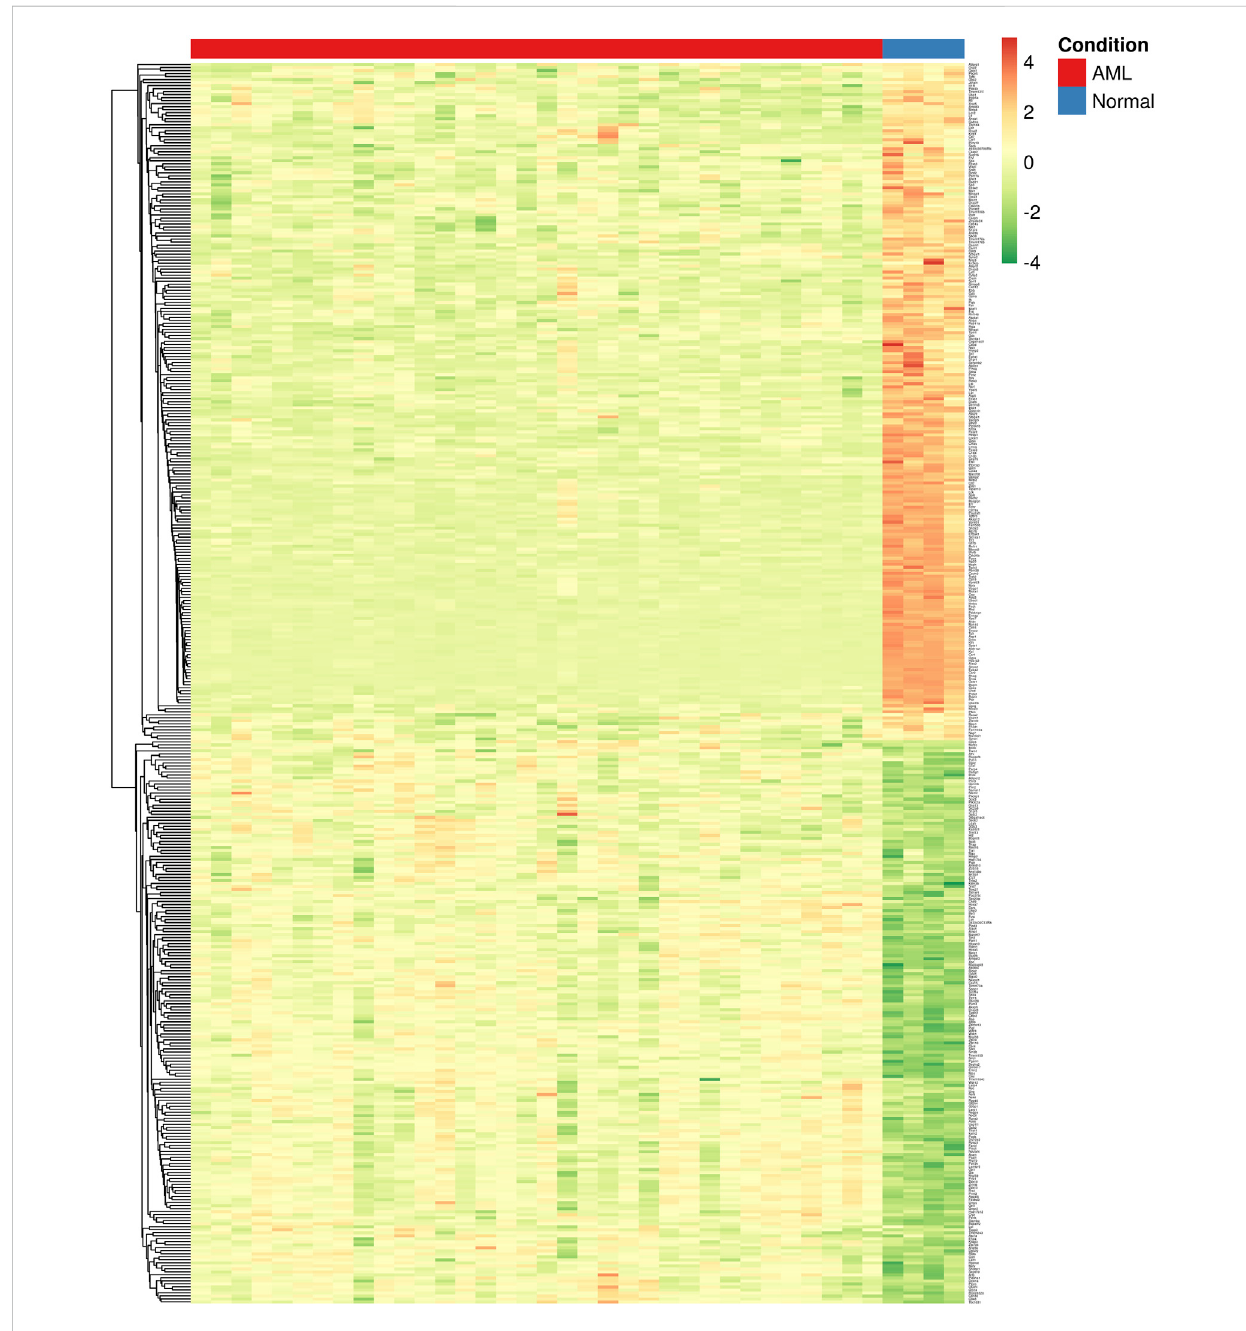
FIGURE 3 Heatmap showing the differential expression of key module genes ( n = 412) in mouse. Each column is a sample, and each row is a gene. The color intensity indicates the level of expression of a speci fi c gene in a particular sample (red indicates high expression and green indicates low